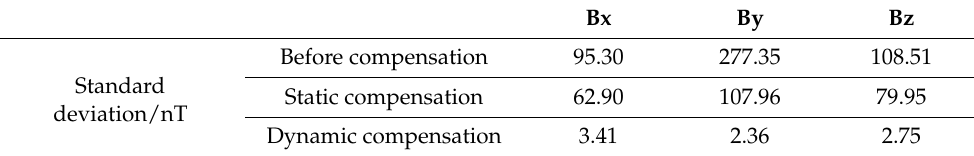
Table 6. Comparison of the mean standard deviations of 10-time